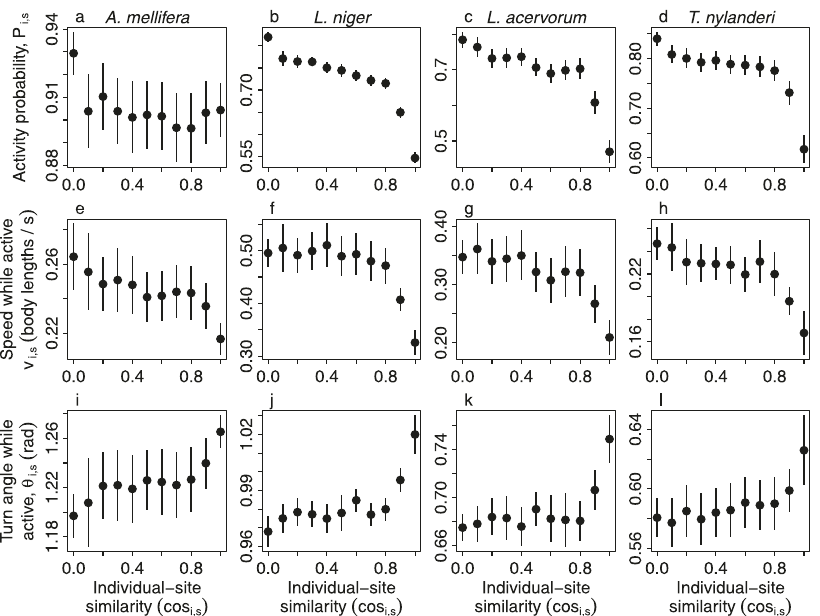
Fig. 6 | Individuals increase their diffusivity when outside their primary mod- ule. a – d Individuals were less active when visiting sites with module scores that were similar to their own, and more active when visiting sites with module scores thatwereverydifferenttotheirown. e – l Activeindividualsmovedmoreslowlyand